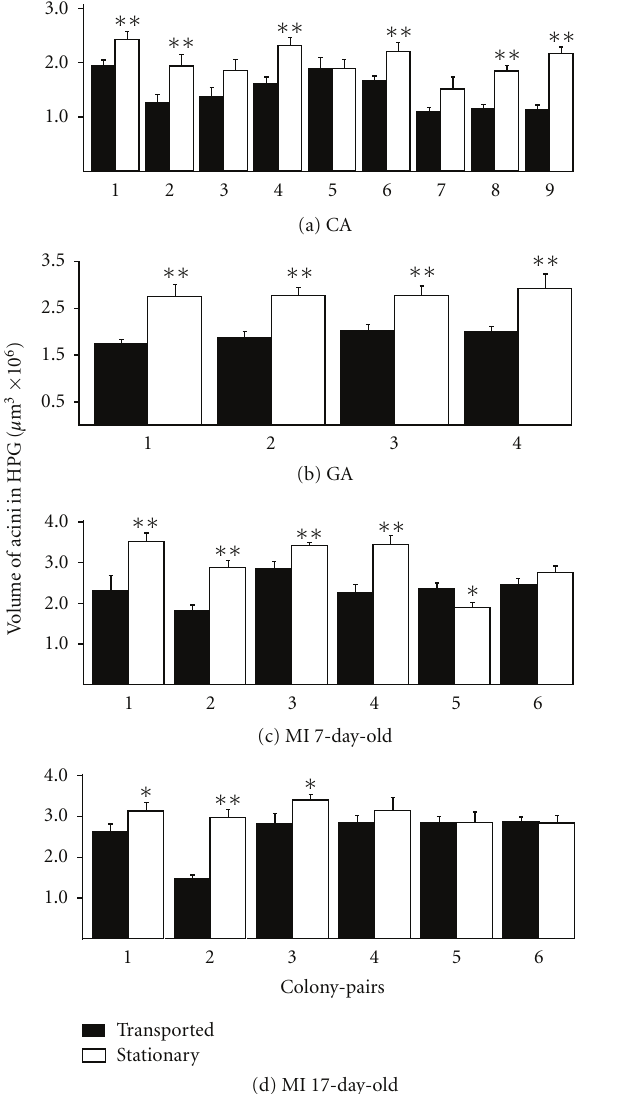
Figure 2: Size of hypopharyngeal glands (mean ± SE) measured as volume of gland acini in worker honey bees experiencing transportation (solid) or no transportation (open) in California (a), Georgia (b), or Michigan ((c), (d)). For more details, see Figure 1 legend.